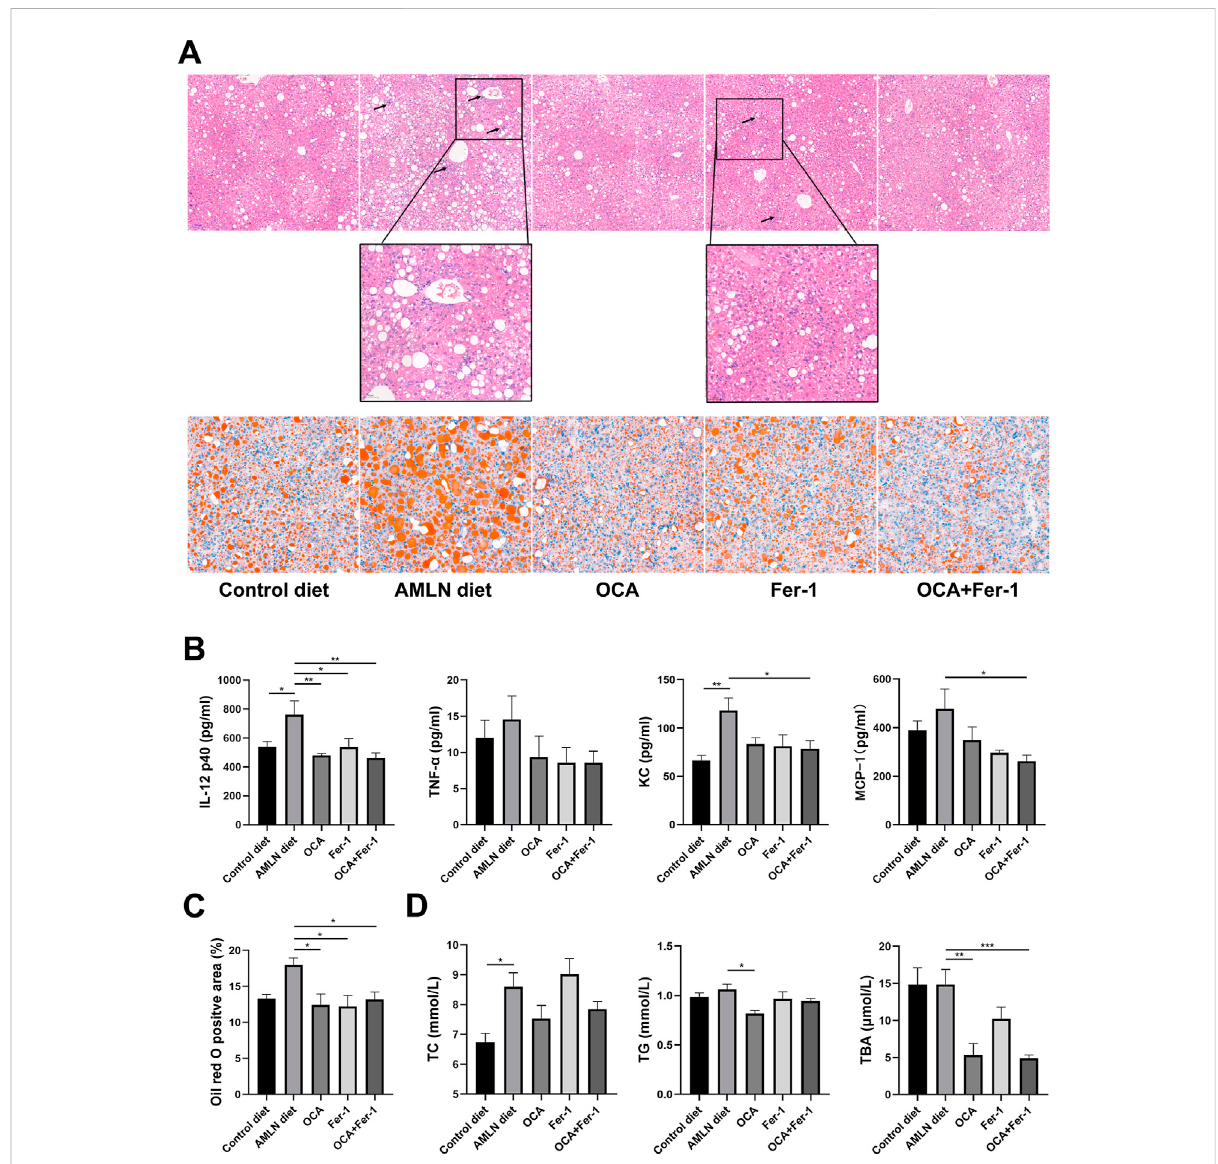
Combination of OCA and Fer-1 signi fi cantly reduced lipid accumulation and in fl ammation. (A) Representative H&E (upper, scale bar: 100 μ m) and Oil red O (lower, upper, scalebar: 50 μ m) staining of liver tissues, theneutrophilin fi ltration area was enlarged and pointed out with black